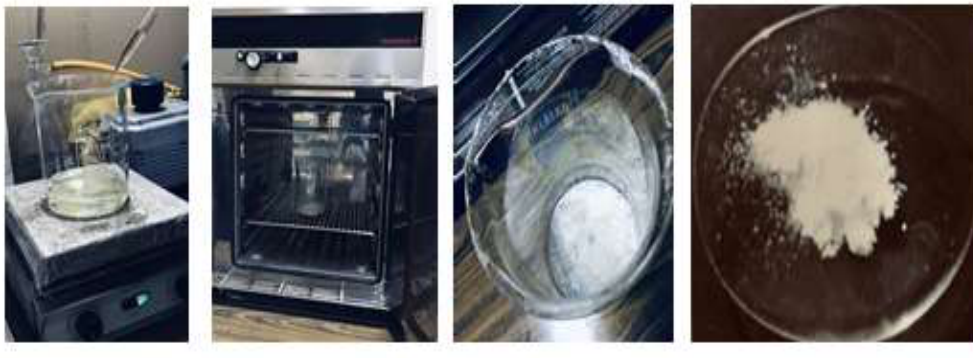
Figure 2 : Steps of synthesis MgO using Sol-gel